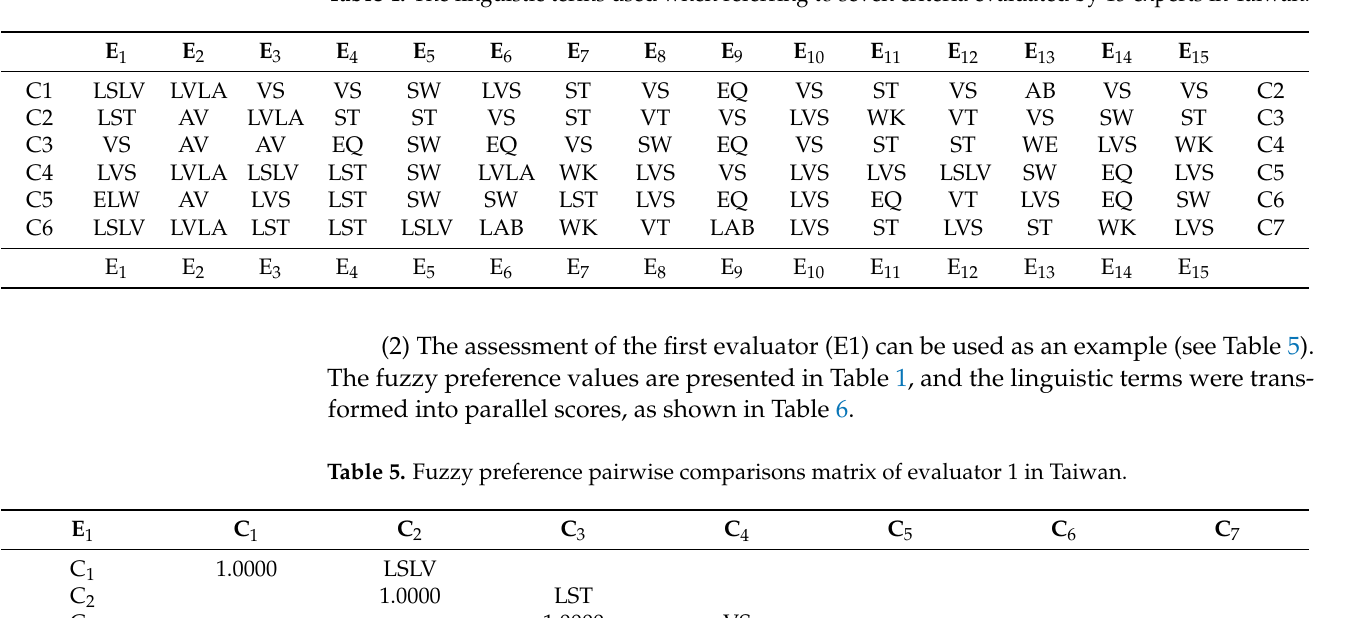
Table 4. The linguistic terms used when referring to seven criteria evaluated by 15 experts in Taiwan.